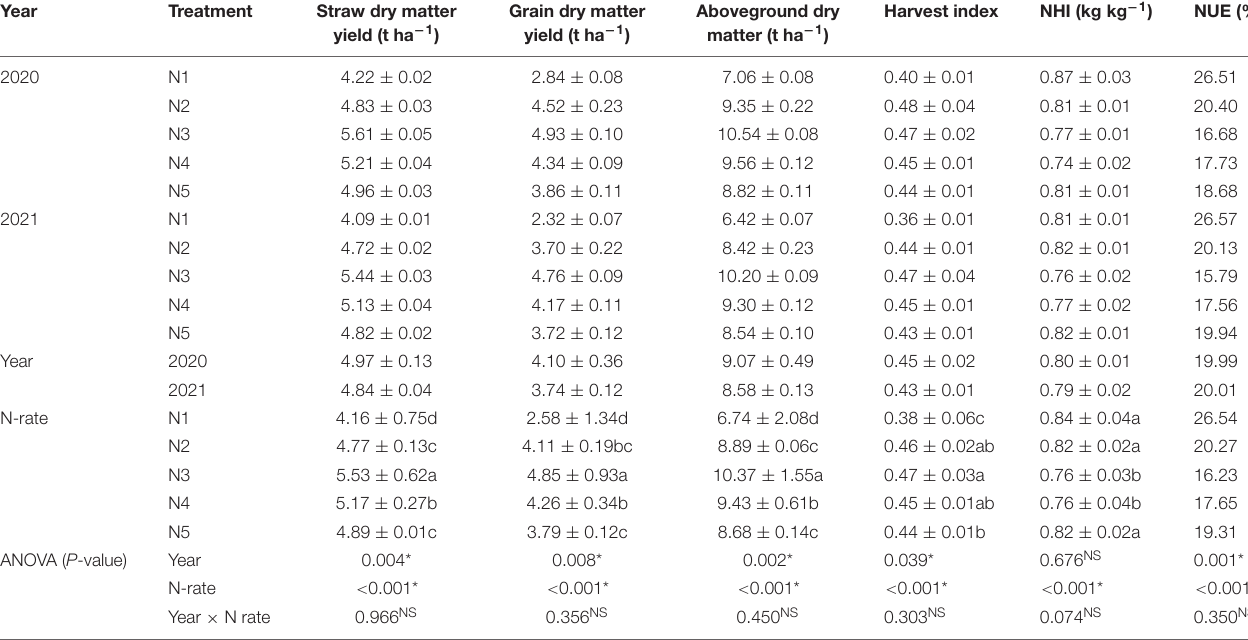
TABLE 2 | Effects of N rate on grain, straw, and aboveground biomass; harvest index (HI), nitrogen harvest index (NHI), and use efficiency (NUE) of spring wheat cultivar.